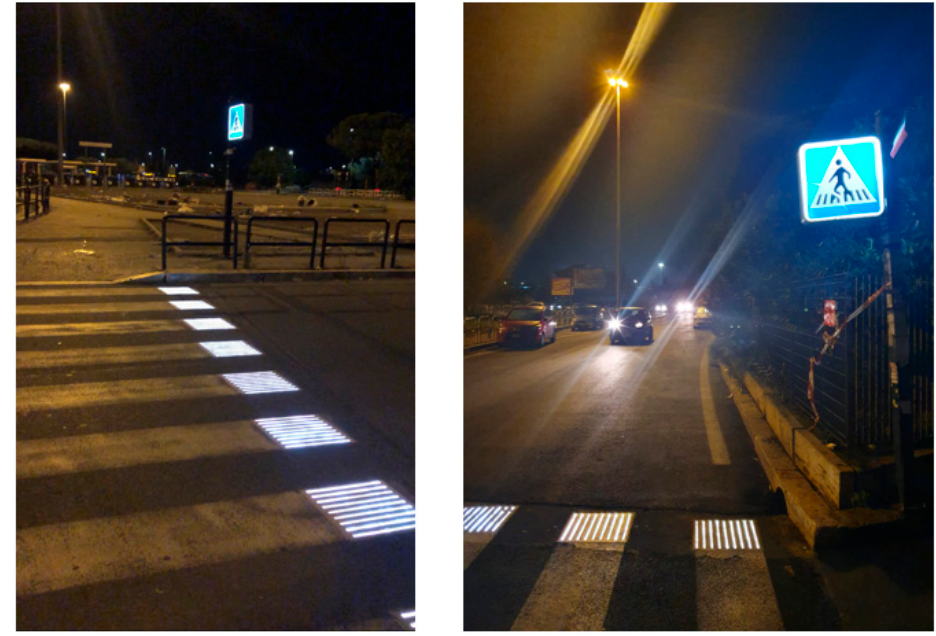
Figure 1. LED lighting system.